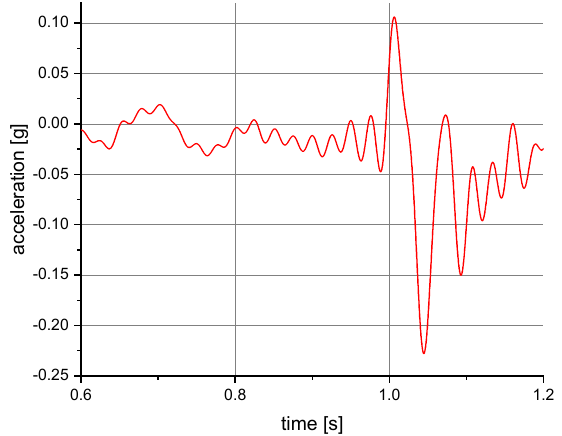
Figure 7. Acceleration as a function of time recorded during tipping. Test conditions: self-locking device at a height of 1.5 m above floor level; back point of the safety harness; the sensor mounted on the back of the manikin.